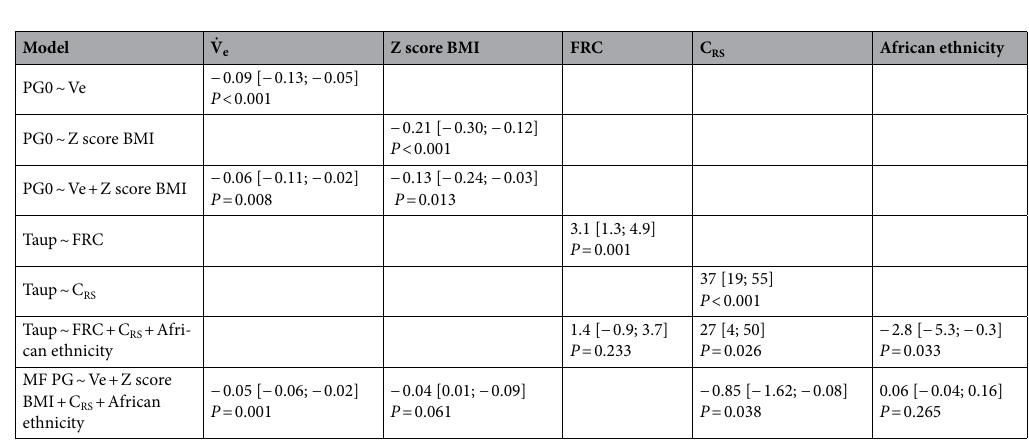
Table 3. Plant correlations. Models are given in the first column and the corresponding model coefficients (unstandardized beta) estimates [95% CI] are shown in the line corresponding to a given